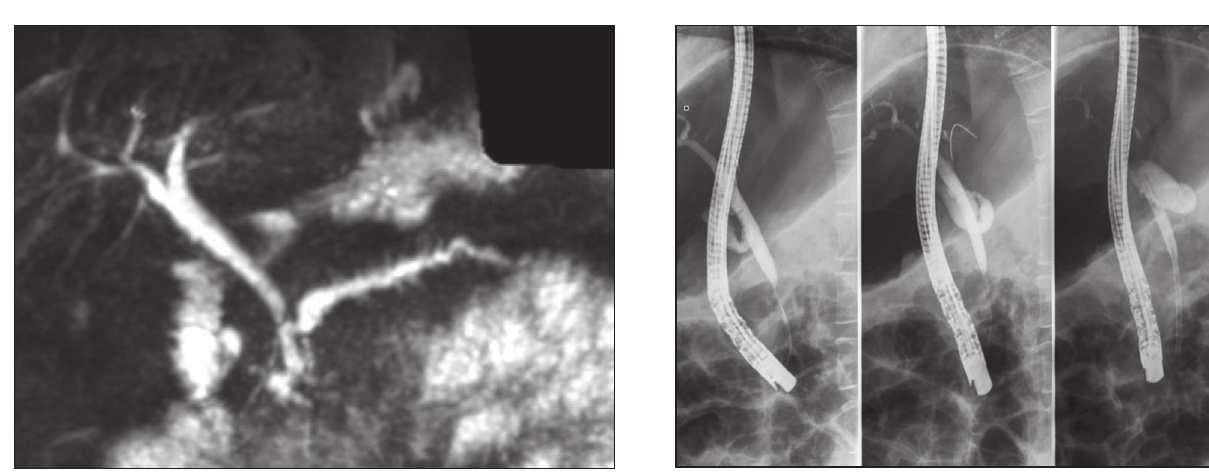
Figure 4) Images from endoscopic retrograde cholangiopancreatography demonstrating the smooth, tapered nature of the distal common bile duct stricture (in contrast to the abrupt ‘cut-off’ which is most often indicative of a malignant